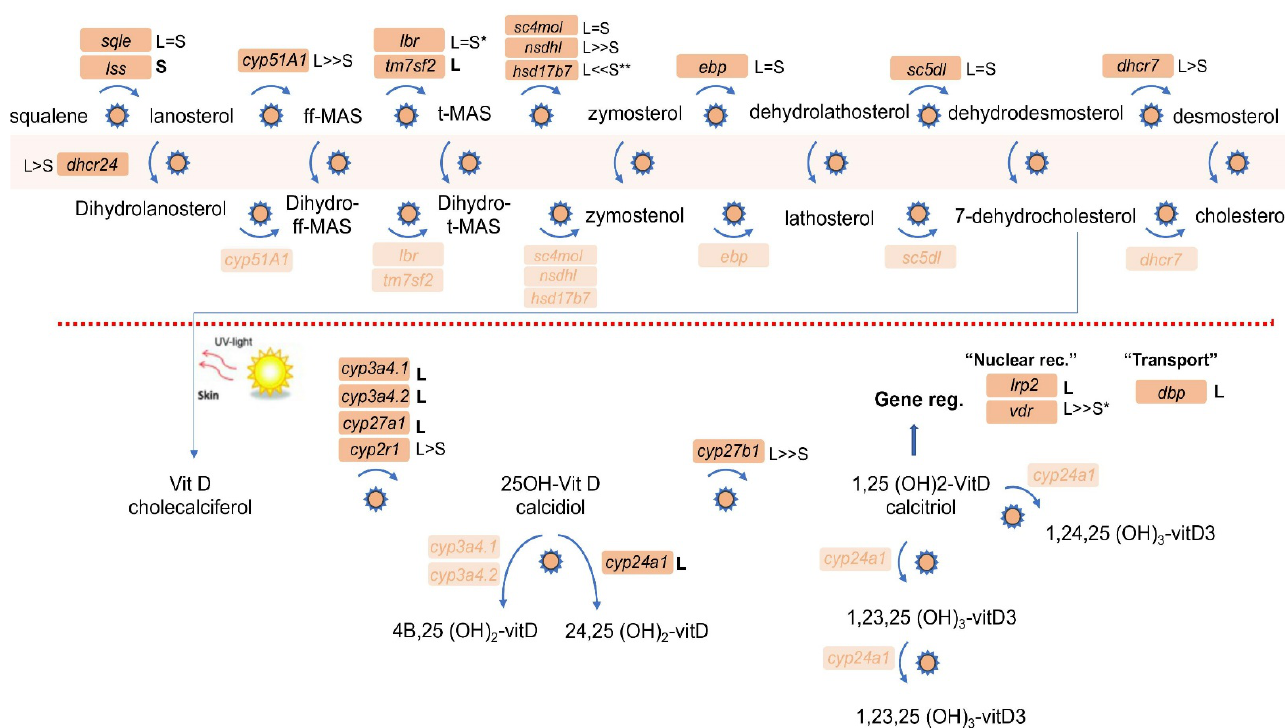
Figure 2. Homoeolog and singleton status of genes involved in vitamin D metabolism and signaling. KEGG analysis of the vitamin D metabolic and signaling network identified 21 genes in the X. laevis genome. The homoeolog/singleton status of each gene is marked (L and/or S). In the metabolic part of the pathway leading to cholesterol production (above the red dotted line), the pathway runs in parallel from lanosterol and dehydrolanosterol. The relative expression levels between homoeologs are summarized: =, similar expression levels; <, 3–6 fold difference; <<, more than 6 fold difference. Asterisks indicate whether temporal expression patterns of the homoeologs are similar (no asterisk), partially divergent (*), or highly divergent (**).